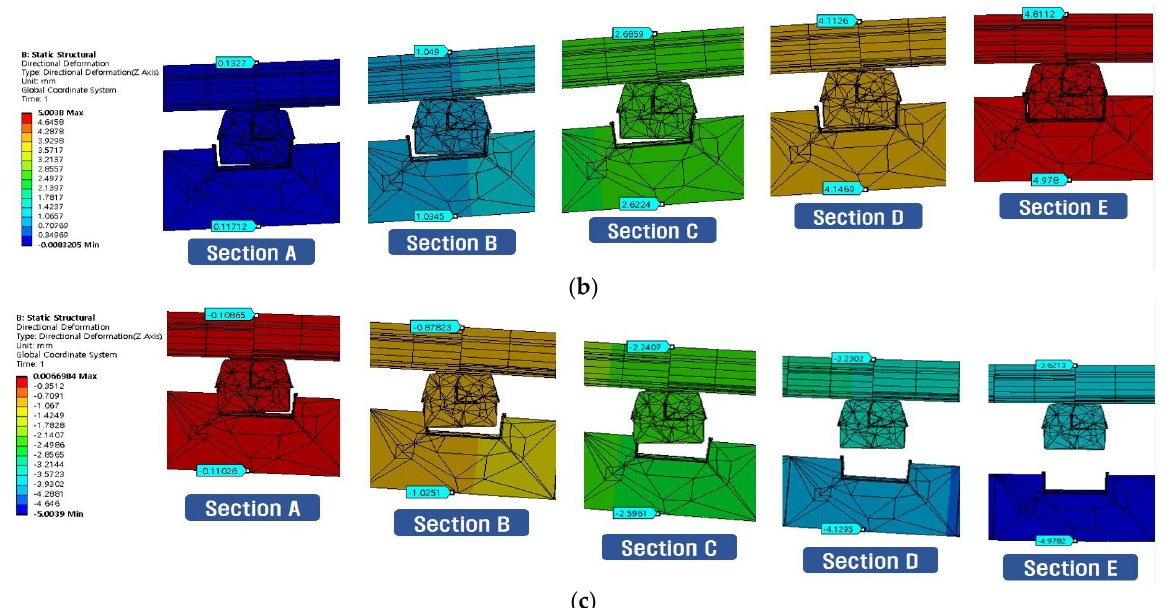
Figure 8. FE analysis results (displacement, z direction), according to location shown in ( a ), for ( b ) 5 mm uplift or ( c ) 5 mm subsidence.